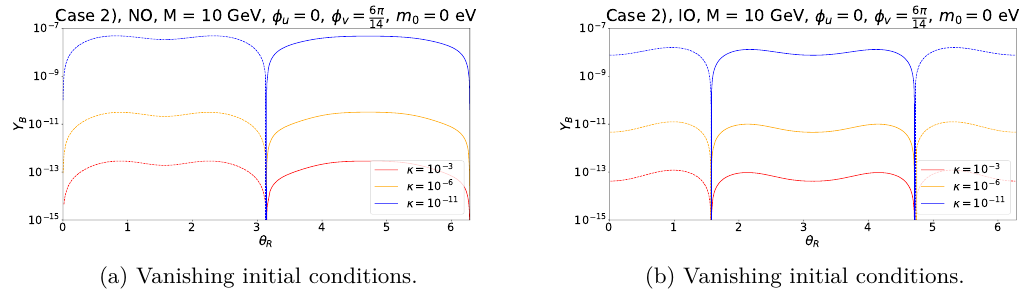
Figure 15 . Case 2) Y B as function of the angle θ R for a Majorana mass M = 10 GeV and different values of κ , κ ∈ { 10 − 3 , 10 − 6 , 10 − 11 } . Results for both light neutrino masses with strong NO (left plot) and with strong IO (right plot) are displayed. Negative (dashed lines) as well as positive (continuous lines) values of the BAU are represented. The parameters ( s, t ) have been fixed to (1 , 2) which corresponds to φ = 0 and φ = 6 π u v 14